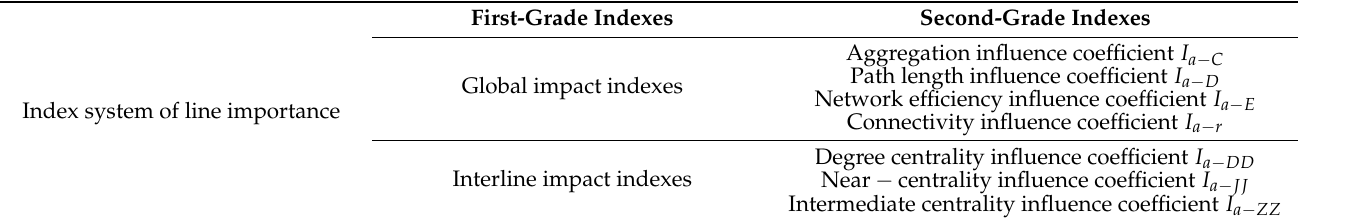
Table 9. Index system of line